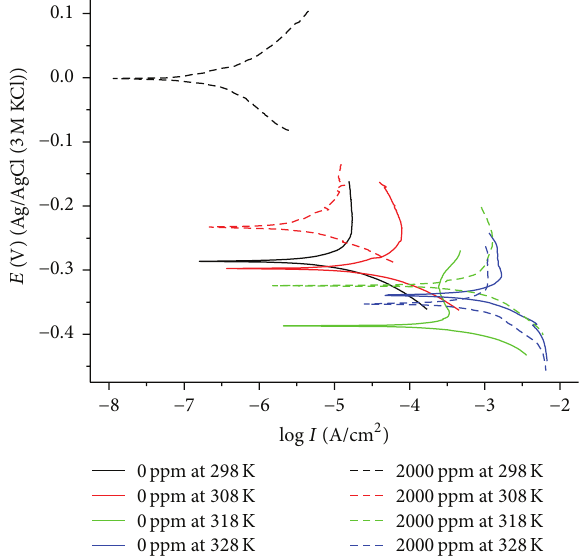
Figure 2: Tafel plots of 304SS in the sulfuric acid 0.5M without and with inhibitor at temperature